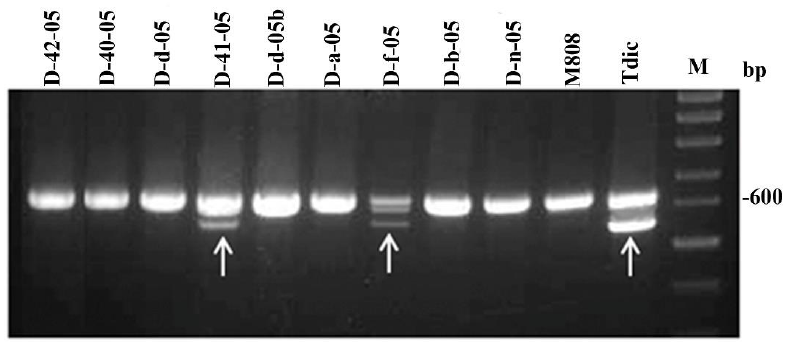
Figure 7. PCR with a combination of primers P40 / P18R for identification of the Dreb-1 gene. The arrows indicate the common band for lines D-41-05, D-f-05, and T. dicoccum , corresponding to the T. dicoccum- specific allele of Dreb-B1 . The upper double band corresponds to the Dreb-A1 and Dreb-D1 genes.